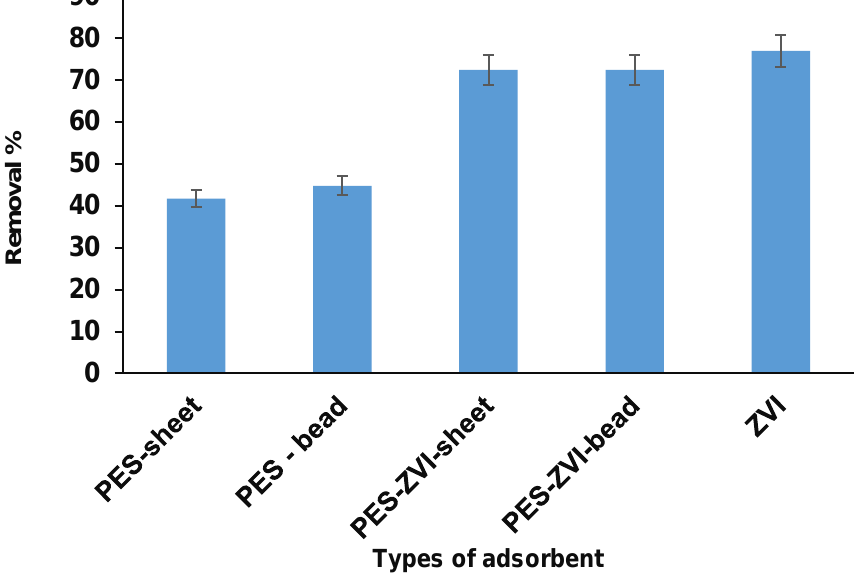
Figure 5. The study of different adsorbents on the uptake of arsenic from apatite-soil treated waters (each material was used 50 mg adsorbent, pH 5, 120 min reaction time, and 20 mg.L -1 arsenic).